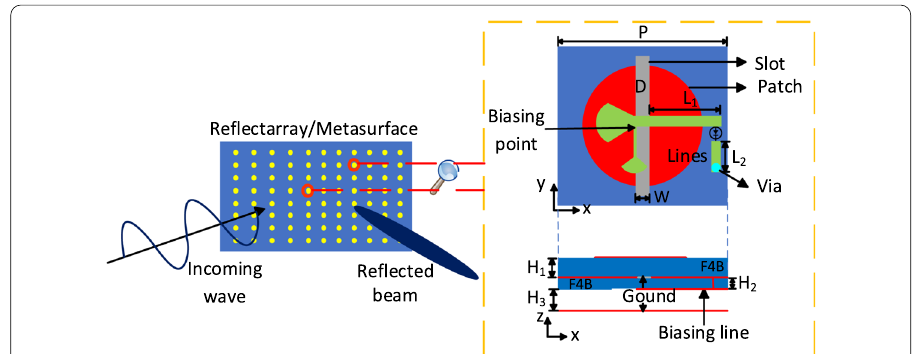
Fig. 2 Reflectarray antennas (also called metasurfaces and smart reflecting surfaces) receive incident waves and reflect them in a specific direction (or to a point in space) in the form of